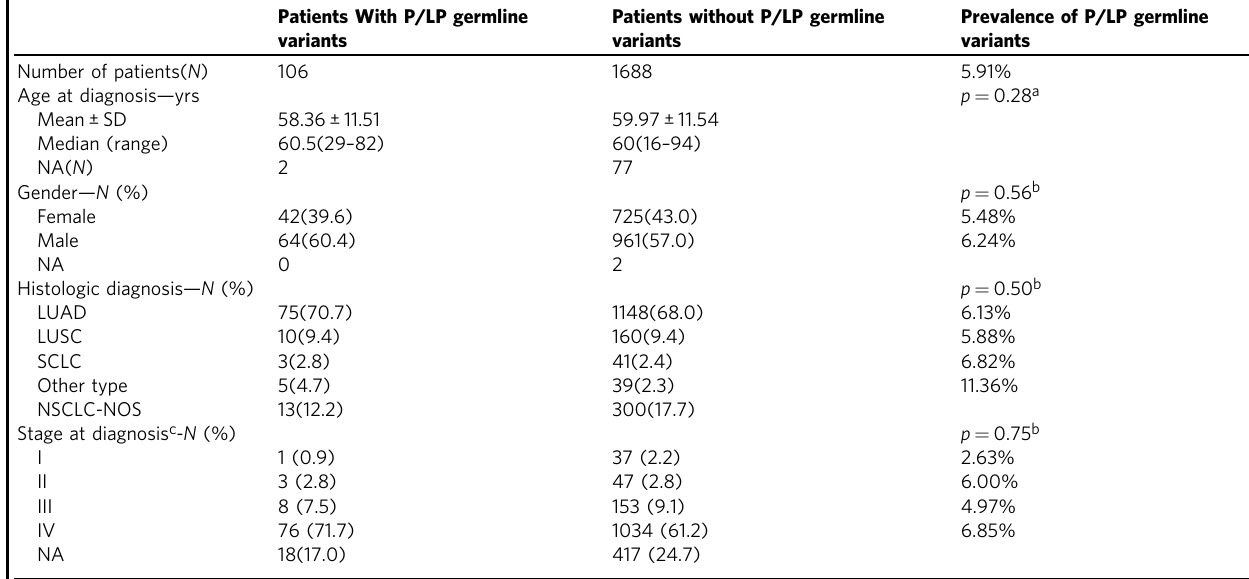
Table 1 Clinical characteristics and prevalence of germline